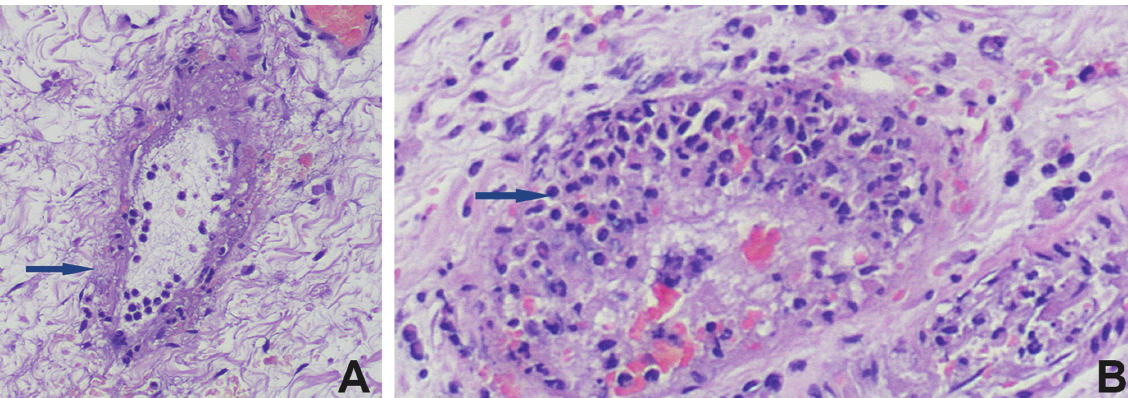
Fig. 2 Necrosis of the vessel wall with neutrophilic in fi ltration was so severe in some areas that vascular structures were barely recognizable: Vasculitis in the intestinal submucosa and fi brinoid necrosis in the vascular wall can be seen ( A , hematoxylin and eosin staining, 100x zoom). Vasculitis seen in the submucosa of the gangrenous in fl amed Meckel ’ s diverticulum. Neutrophile granulocytes and fi brinoid necrosis deposits in the vascular wall ( B , hematoxylinand eosin staining, 100x